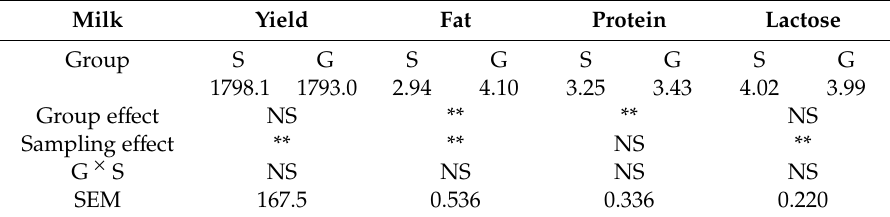
Table 2. Milk yield (g / head / day) and chemical composition